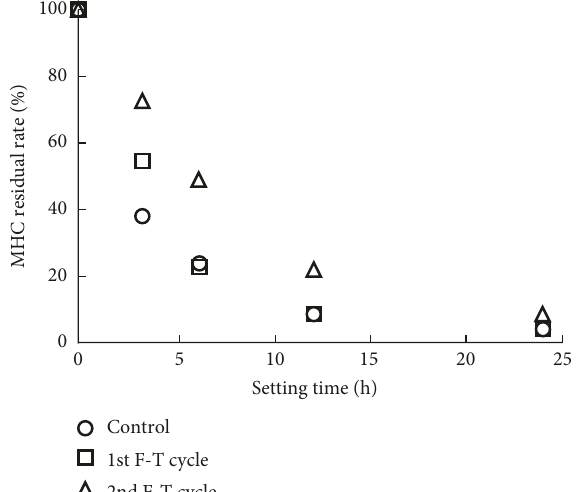
Figure 9: Changes in MHC residual rate of two-step gel prepared from each frozen surimi with setting time.